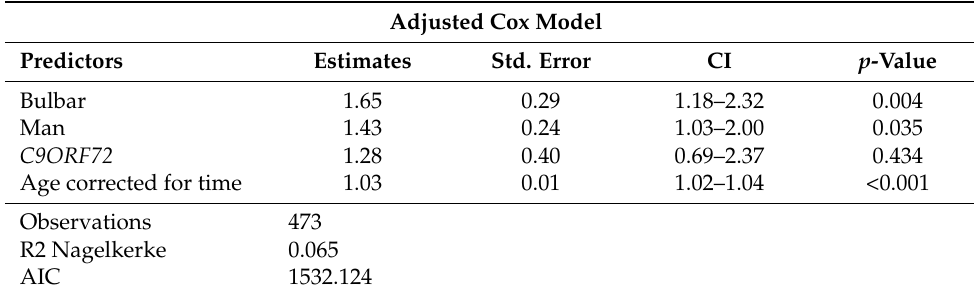
Table 3. Adjusted Cox model for phenotype. For this model, given two subjects with different phenotypes alive at a determined time, the risk of death at any time thereafter for the patient with the bulbar phenotype is expected to be 65% higher than that for the spinal phenotype (HR 1.65). Age corrected for time refers to the time elapsed between onset and diagnosis.